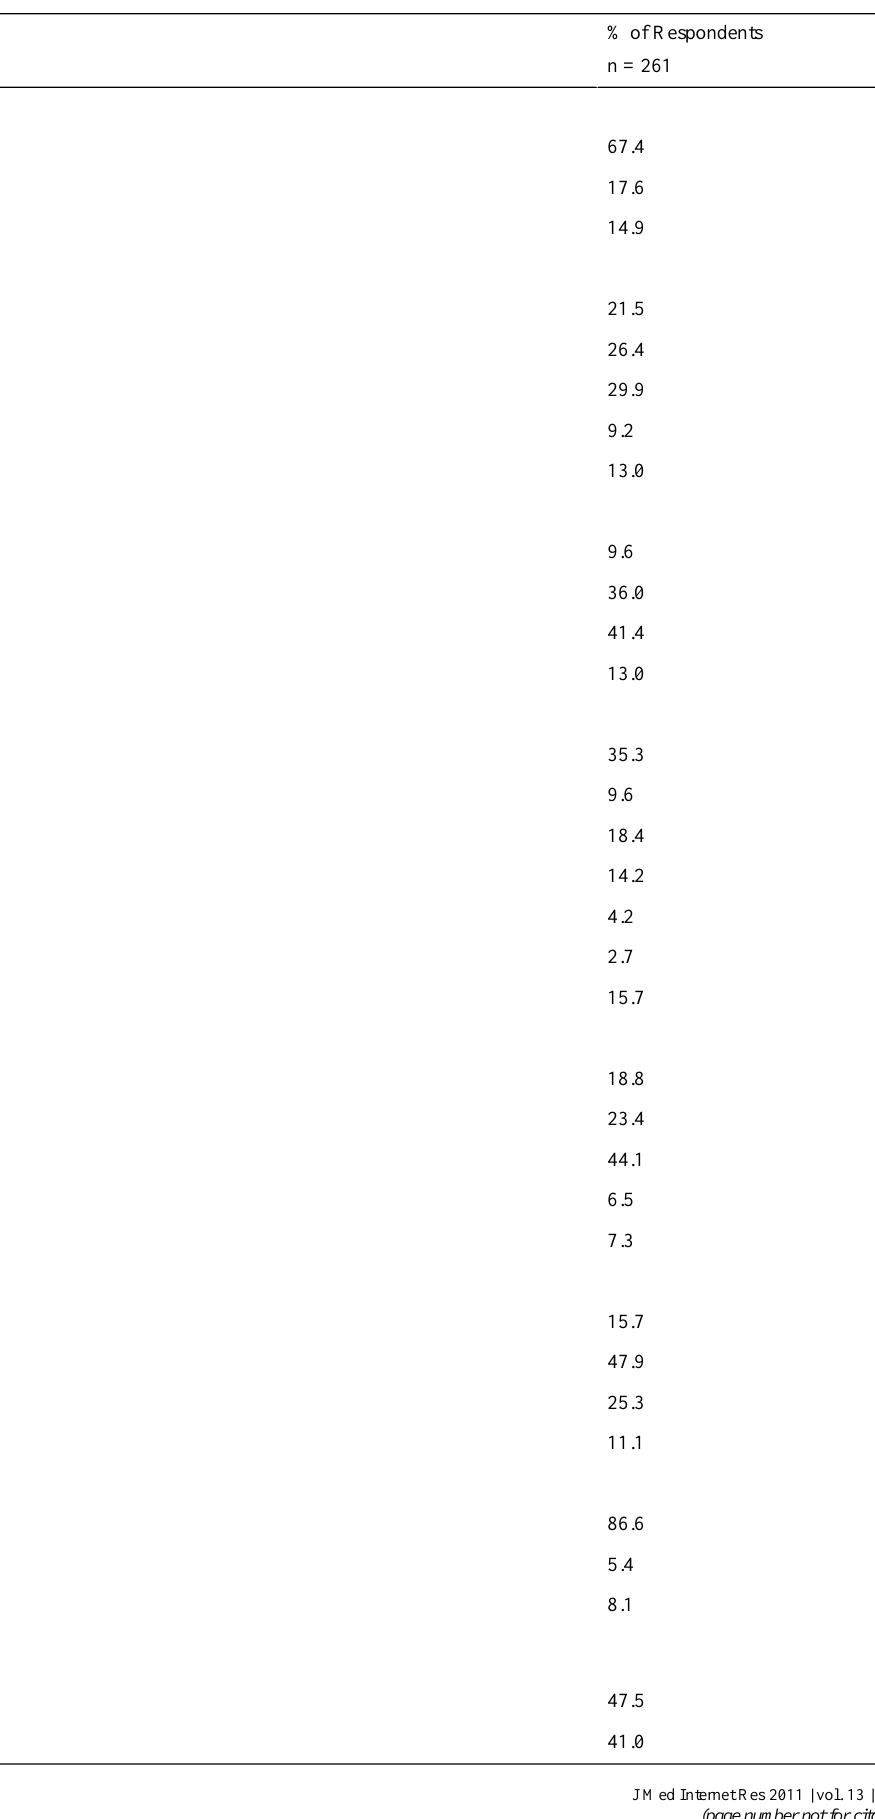
Table 2. Characteristics of respondents